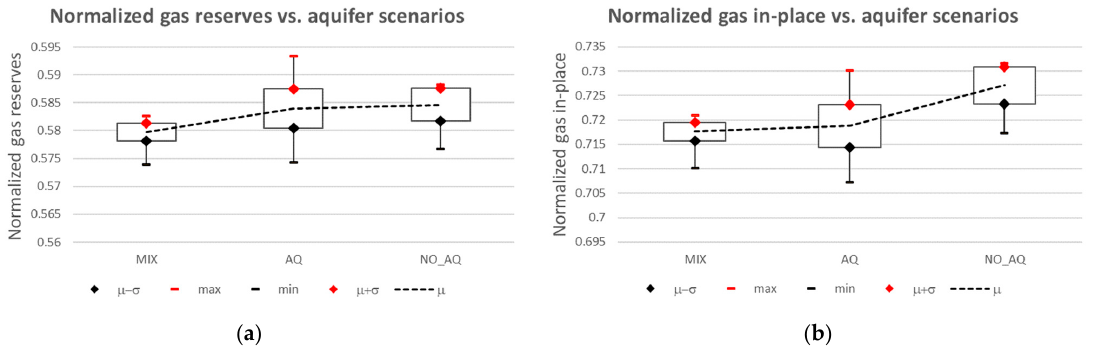
The impact of history match quality to the modelling uncertainty. a) Gas reserves, b) in-